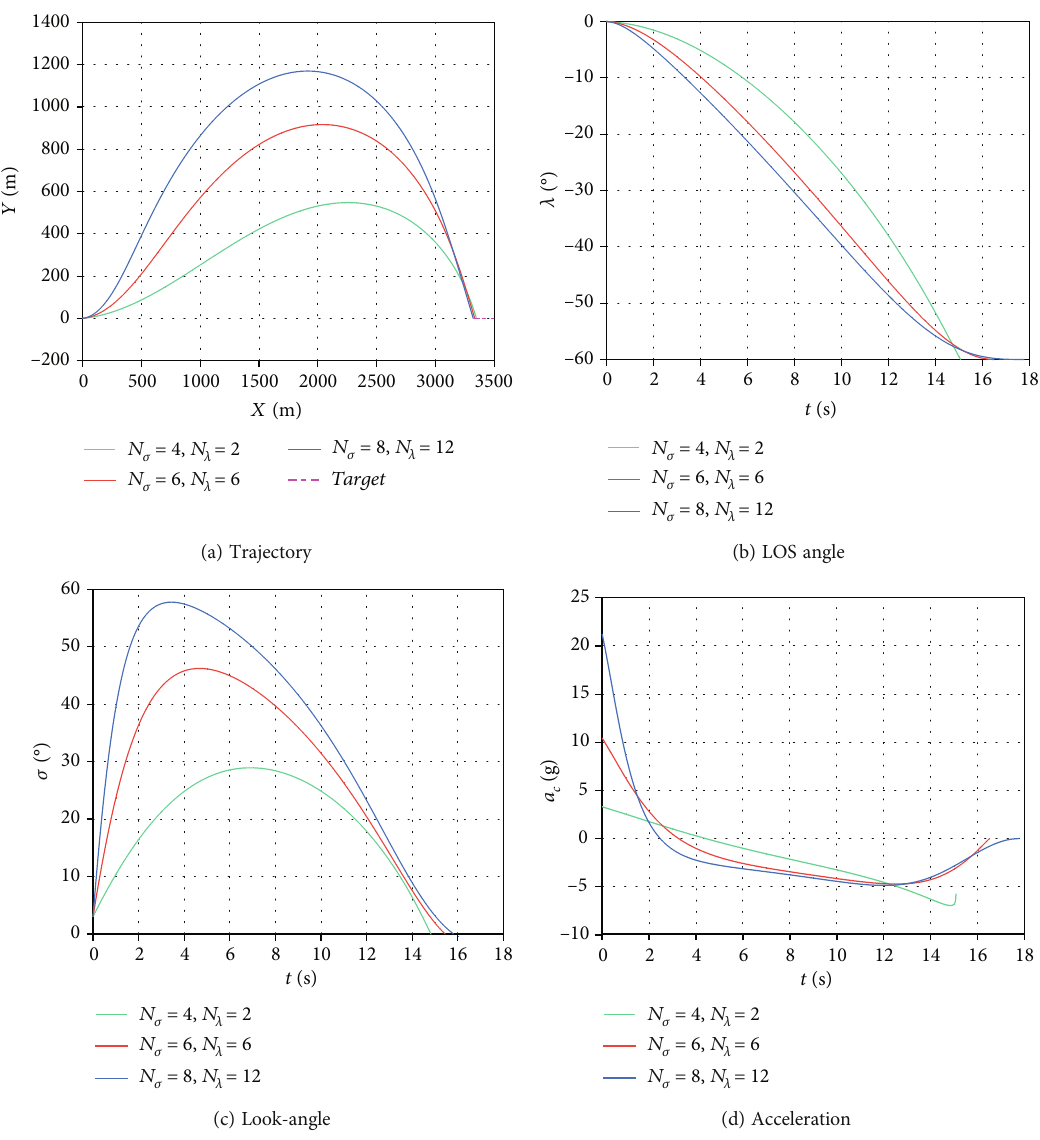
Figure 4: The results of di ff erent guidance coe ffi cients without FOV constraints.